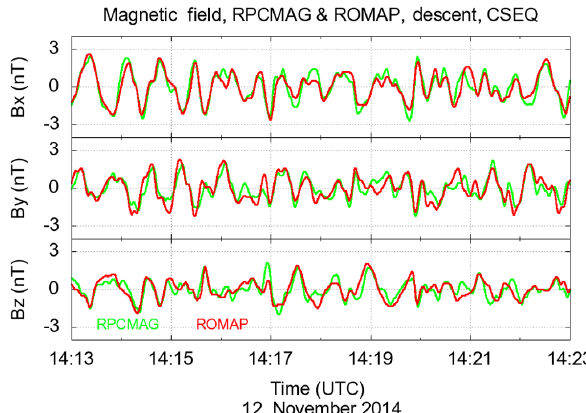
Figure 5. An example of 10min parallel measurements of RPC- MAG & ROMAP data during the PHILAE descent. Waves with frequencies of ∼ 30mHz can clearly be seen in both time